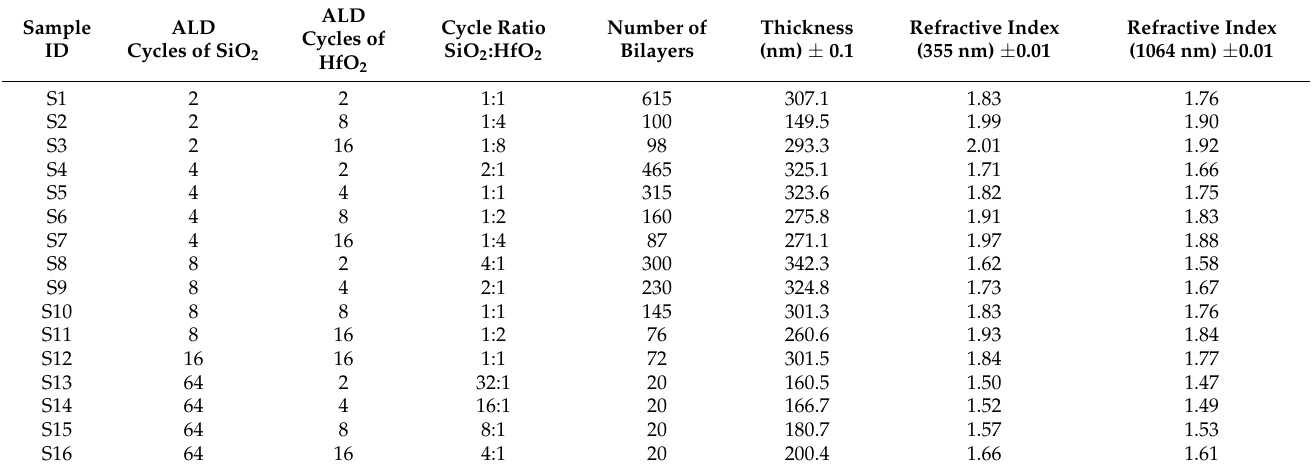
Table 2. The composition, total thickness, and refractive indices of SiO 2 :HfO 2